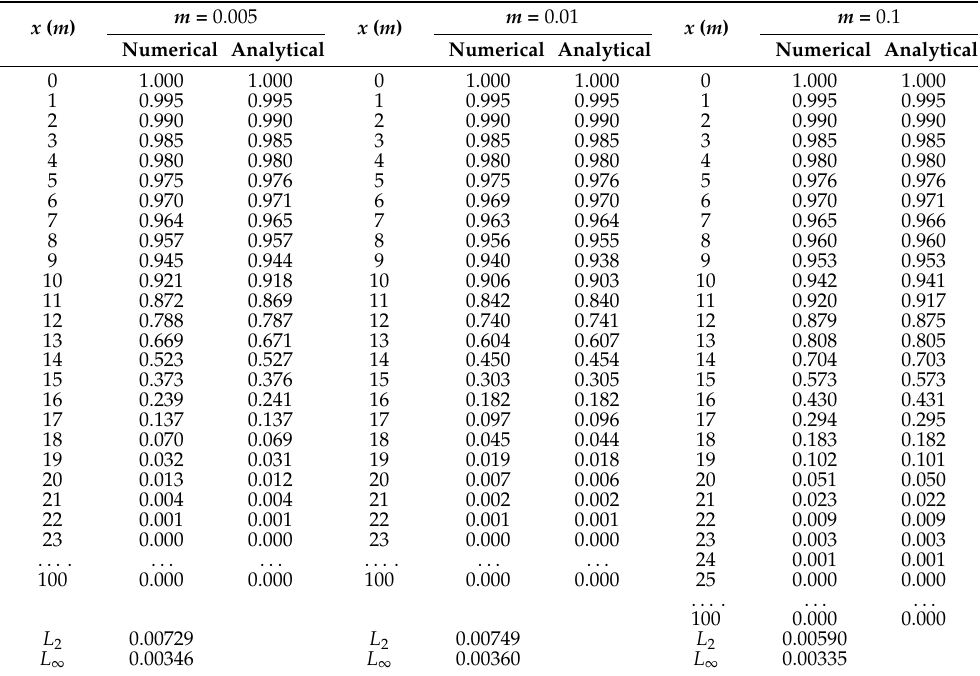
Table 7. The numerical results of the ERK4-NCCD scheme for ∝ = 0.05 m − 1 and ∆ t = 1 s with different m values at t = 1500